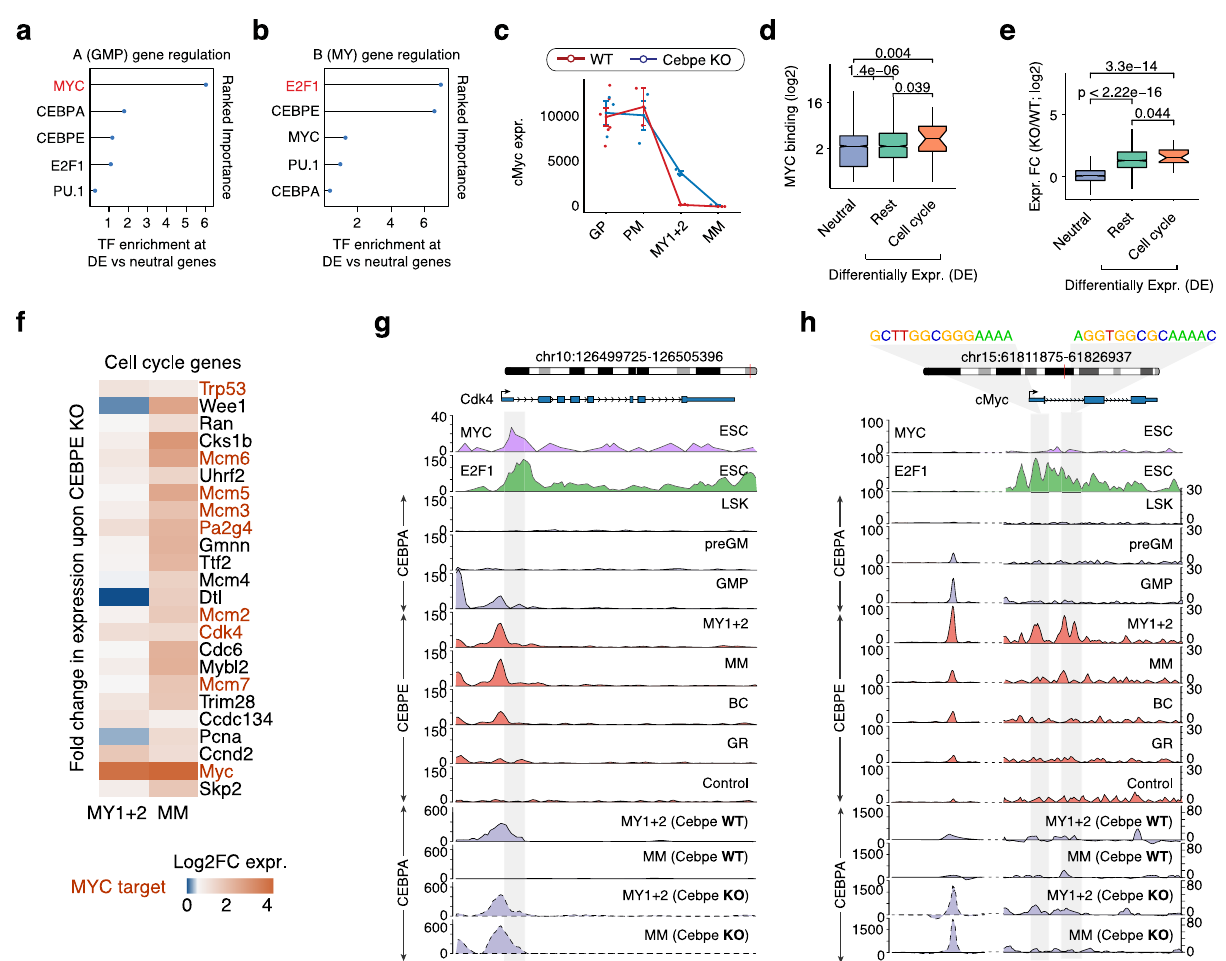
Fig. 4 CEBPE inhibits G1/S progression by repression of MYC target gene expression. a , b Ranked importance of fi ve TFs (MYC, E2F1, CEBPE, CEBPA, and PU.1) in classifying genes from A(GMP) and B(MY) gene clusters that are differentially expressed (DE) in Cebpe KO vs. Cebpe WT mice as compared to neutral genes, respectively. Ranked importance is inferred by fi tting a generalized regression model (GLM) to the binding af fi nities of the fi ve TFs at gene promoters (DE vs. neutral). c Expression pro fi le of Myc during normal granulocytic differentiation (i.e., in GPs ( N = 6 WT and 3 KO), PMs ( N = 2 WT and 3 KO), MY1s + My2s ( N = 3 WT and 3 KO), MMs ( N = 3 WT and 3 KO) biological replicates) in Cebpe WT and KO mice (mean; whiskers represent the standard error). d MYC binding levels at the promoter of genes (cluster A(GMP)) classi fi ed based on their log2-fold differential expression in Cebpe KO vs. Cebpe WT mice (DE vs. neutral). DE genes are further subdivided as key regulators of the G1/S phase vs. rest (center line, median; box limits, upper and lower quartiles; whiskers, 1.5x interquartile range) ( N = 2856 neutral, 1452 rest, and 23 cell cycle) (Wilcoxon test, one-sided). e Same as ( d ), showing log2-fold DE genes subdivided as key G1/S phase regulators vs. rest as compared to neutral genes. f Aberrantly upregulated cell cycle genes (cluster A(GMP)) in MY1s + MY2s and MMs of Cebpe KO mice. Known MYC-target genes are highlighted in red. g , h Genome browser view of CEBPA, CEBPE, MYC, and E2F1 binding in WT and Cebpe KO mice (only CEBPA) to cis-regulatory elements of the G1/S phase cell cycle regulators, Cdk4 ( g ) and Myc ( h ). Highlighted sequences represent E2F1 binding sites. Source data are provided as a Source Data fi